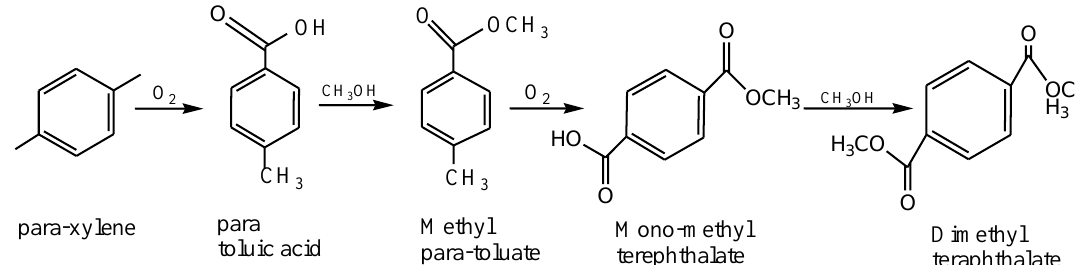
Figure 8 . Reaction for the synthesis of a dibasic acid terephthalate. Figure 8. Reaction for the synthesis of a dibasic acid terephthalate.